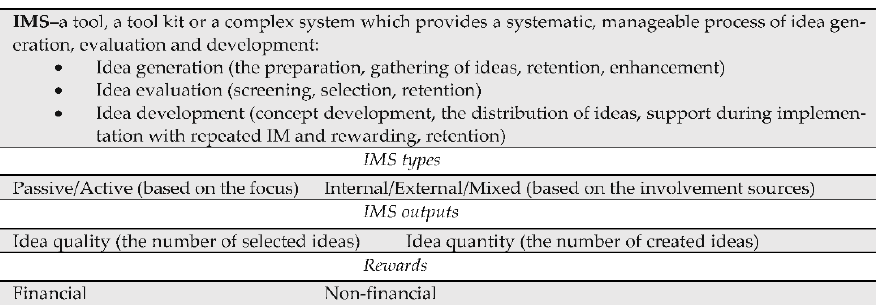
Figure 11. The Main Concepts of the Paper.